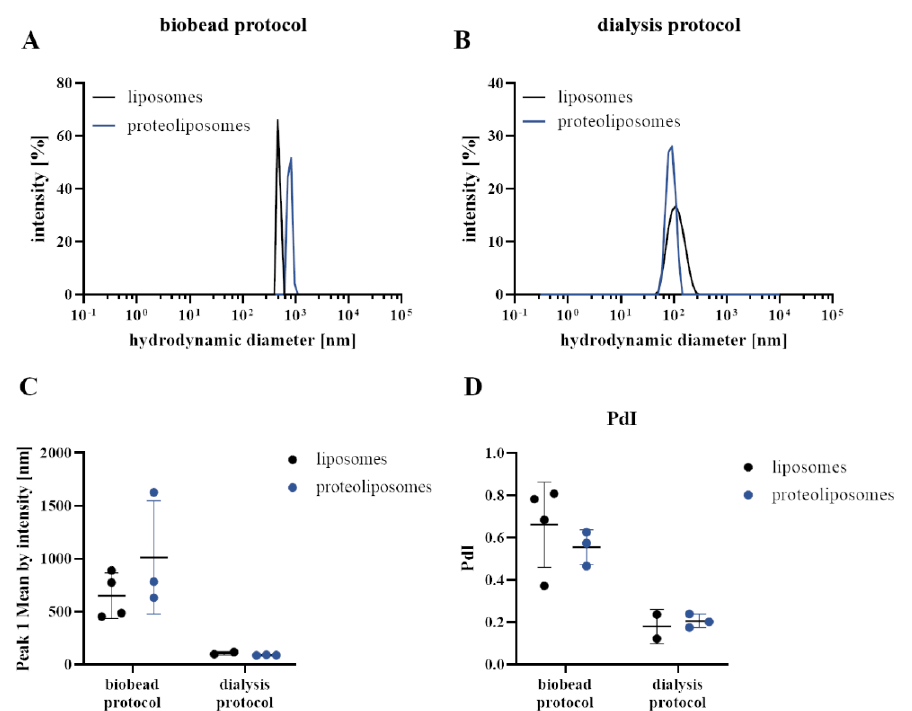
Figure 1. Size distribution of Ld/Lo αIIbβ3 proteoliposomes and empty liposomes reconstituted with different protocols. ( A ) Representative DLS data showing the size distribution of liposomes (black) and proteoliposomes (blue) consisting of DOPC:SM:cholesterol (45:30:25) prepared with the biobead or ( B ) with the dialysis protocol measured at 37 °C. ( C ) Peak 1 mean by intensity and ( D ) polydispersity indices (PdI) from (proteo-)liposome DLS data of at least two independent measurements are shown in dot plots with mean ± SD. Corresponding autocorrelation functions are presented in Figure S2.